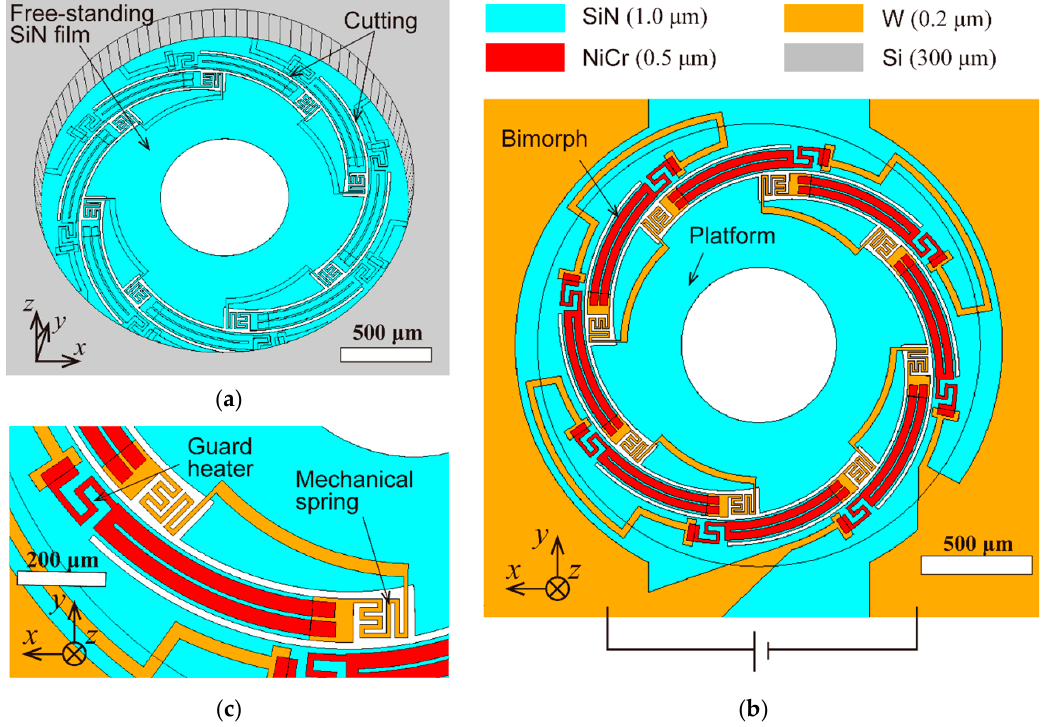
Figure 2. Design of the electrothermal kirigami scanner: ( a ) frontside perspective view of freestanding SiN film (1.0 µ m thickness, 2 mm in diameter) on which the spiral-curved cuttings are strategically placed; ( b ) backside view of SiN film where NiCr patterns (0.5 µ m thickness) and W patterns (0.2 µ m) are deposited; ( c ) backside detailed view of the thermal bimorph beam.